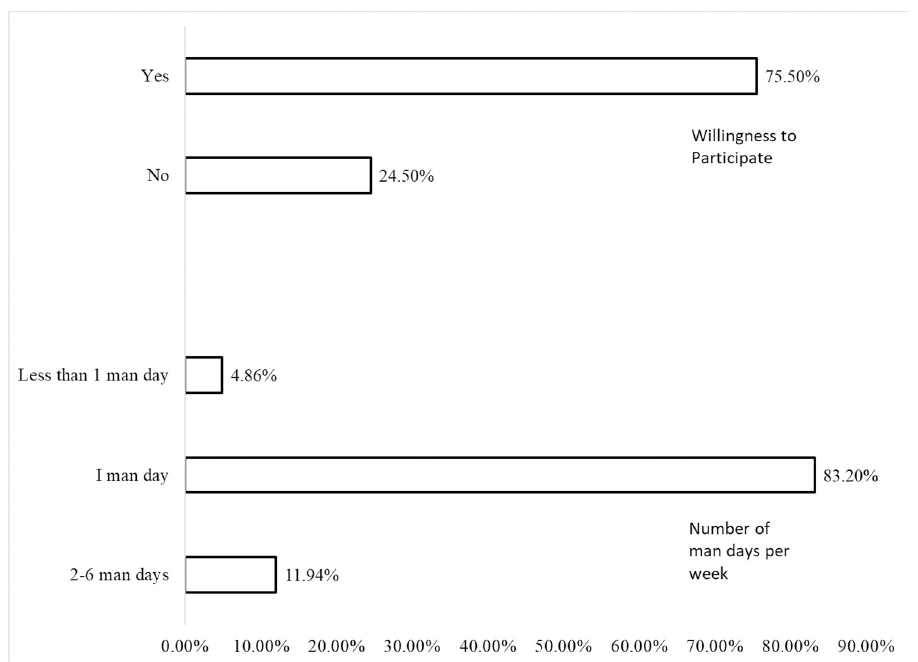
Fig 5. Result of the willingness of the respondents to participate in a cleanup of road gutters/drainage channels program and the number of man-days they are willing to contribute.